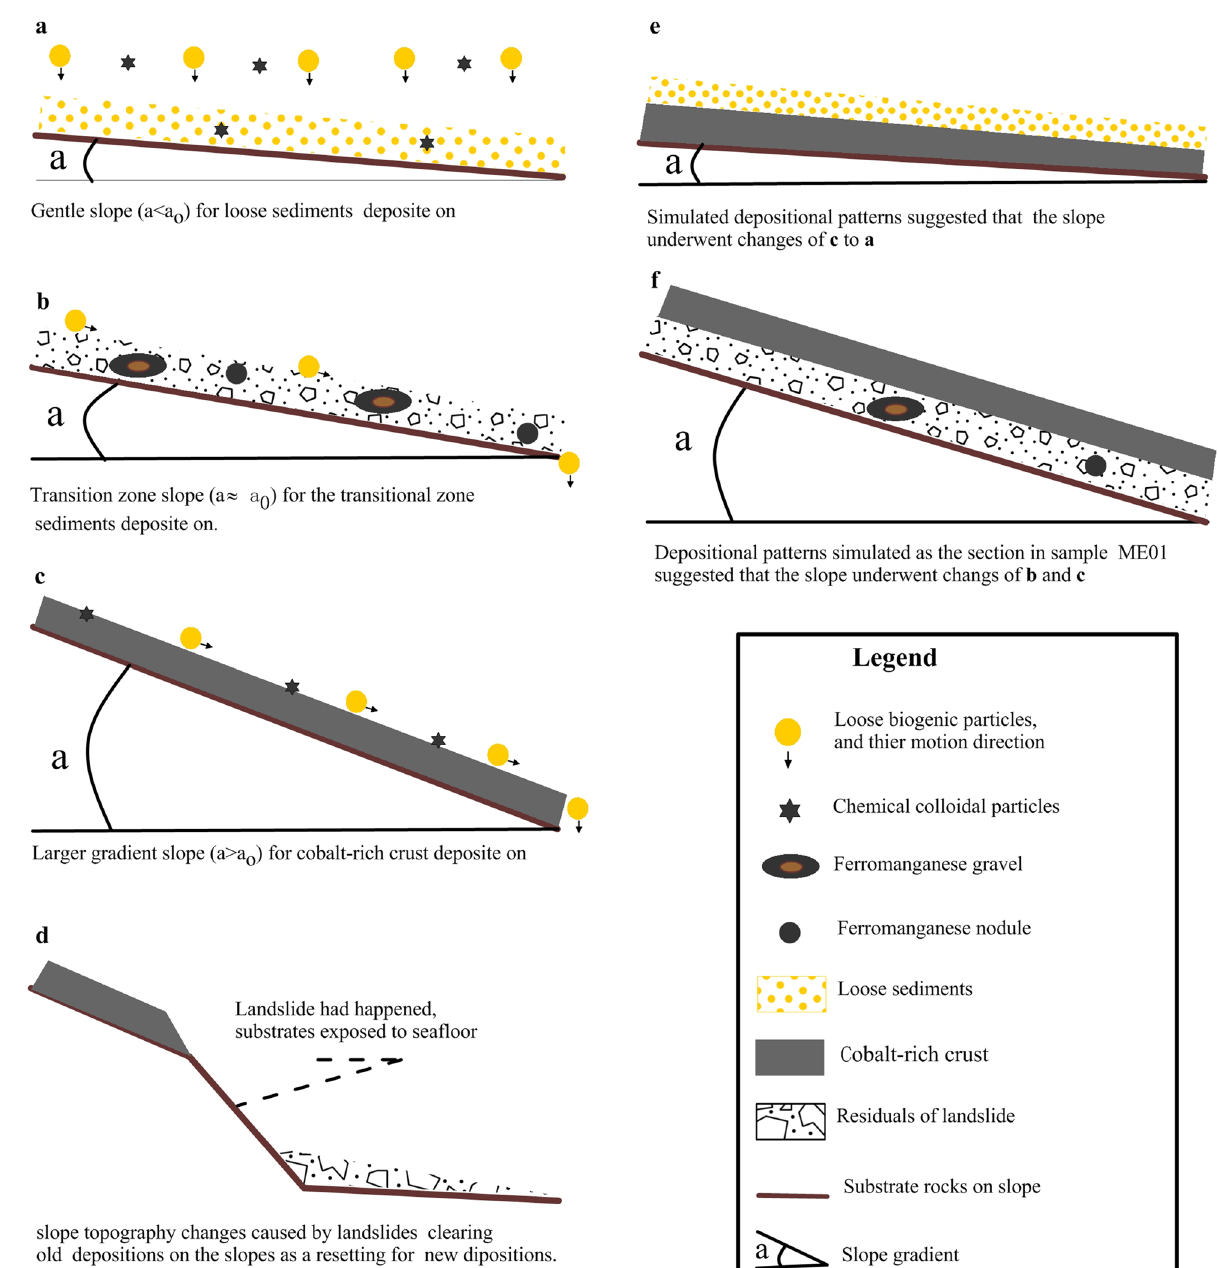
Figure 6. Deposition patterns constrained by changes to seamount slope